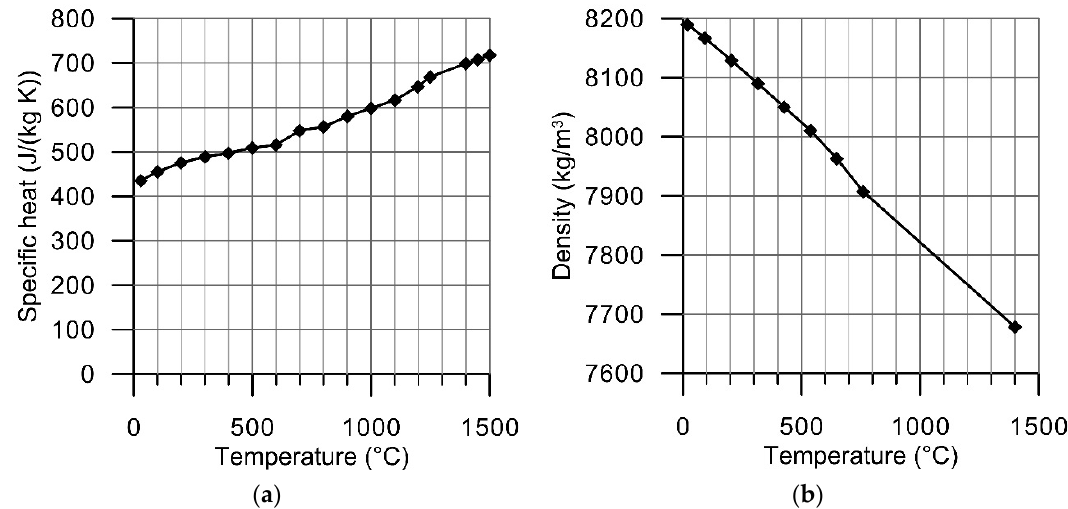
Figure 4. Thermal dependence of: ( a ) specific heat [41], ( b ) density.